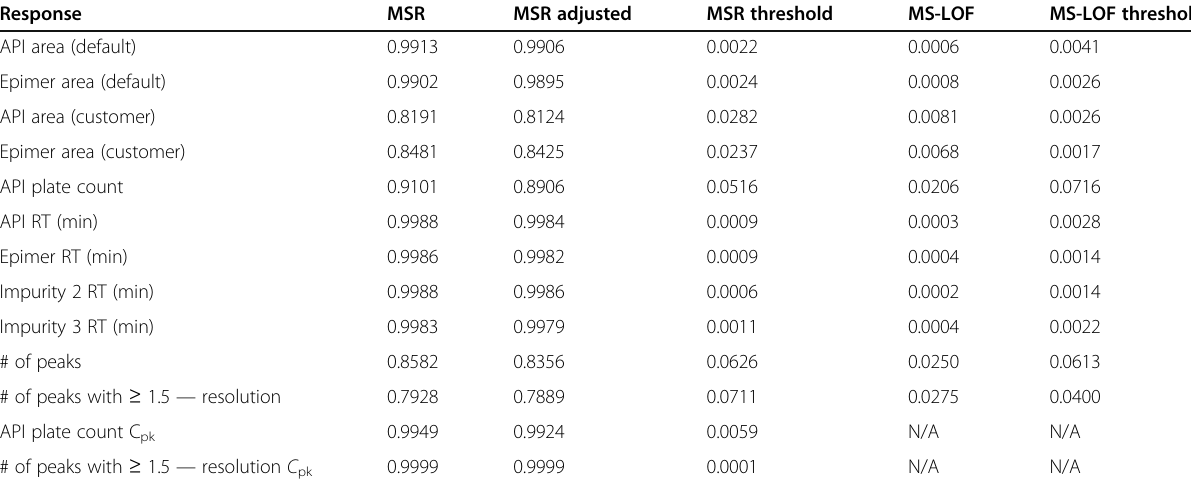
Table 2 Major model regression statistics of various chromatographic responses Response